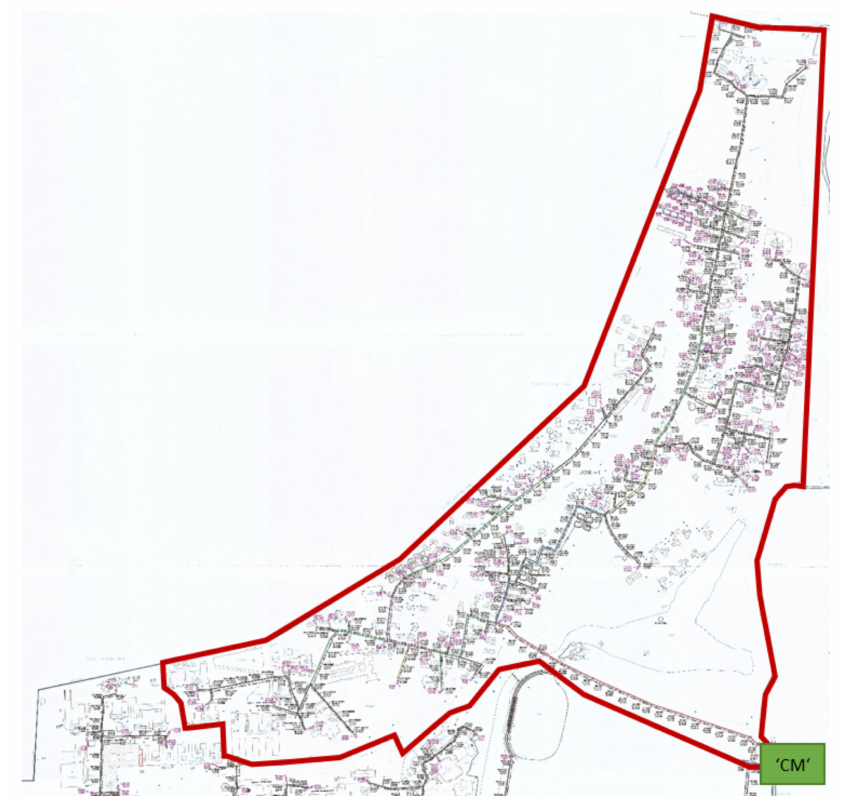
Figure 6. Sewerage network in IIT Madras (region above the green line is Zone 1).